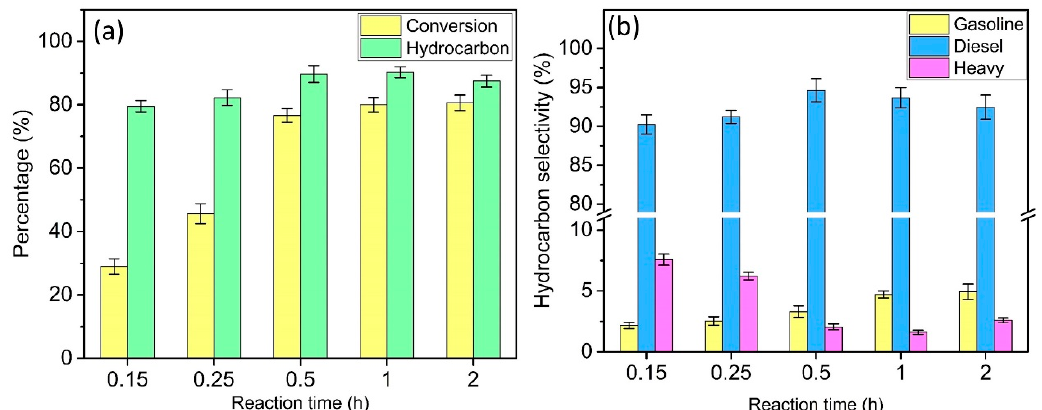
Figure 7. Effect of reaction time on ( a ) conversion and hydrocarbon product and ( b ) hydrocarbon selectivity from deoxygenation of triolein over DP-Y65. selectivity from deoxygenation of triolein over